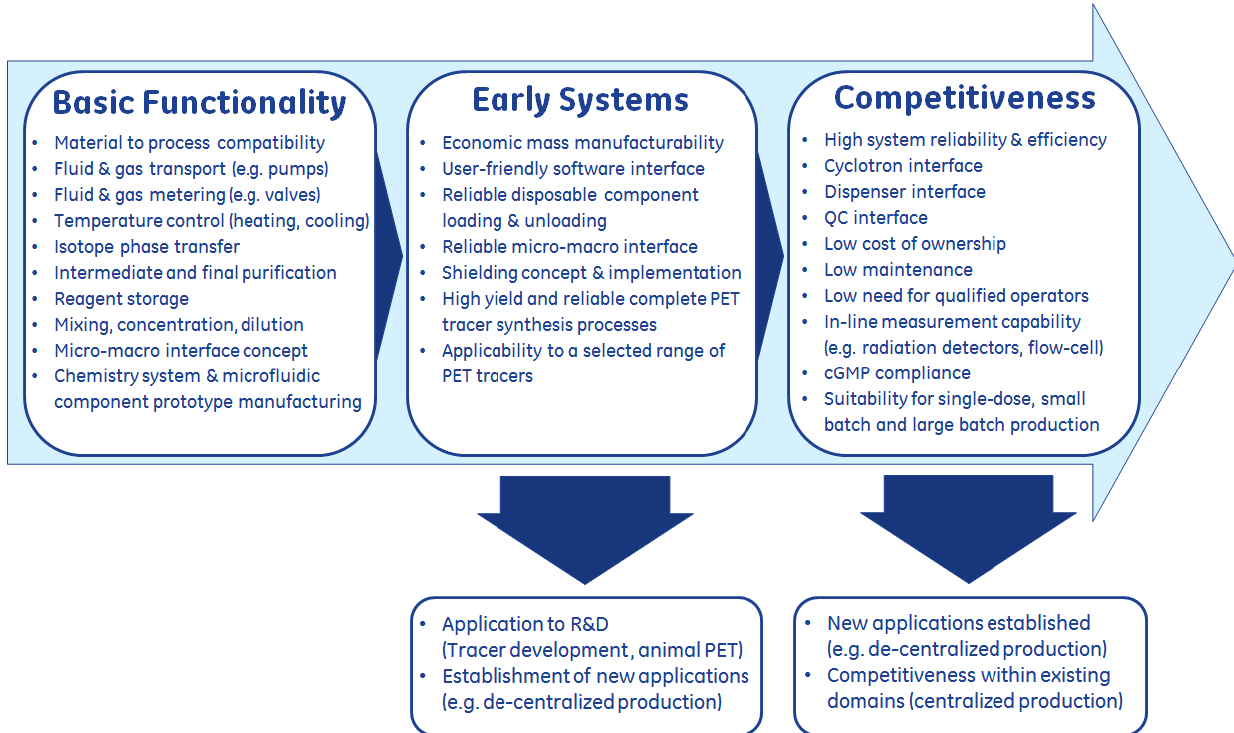
Figure 2. Evolution of microfluidic PET tracer synthesis systems and application to existing and new